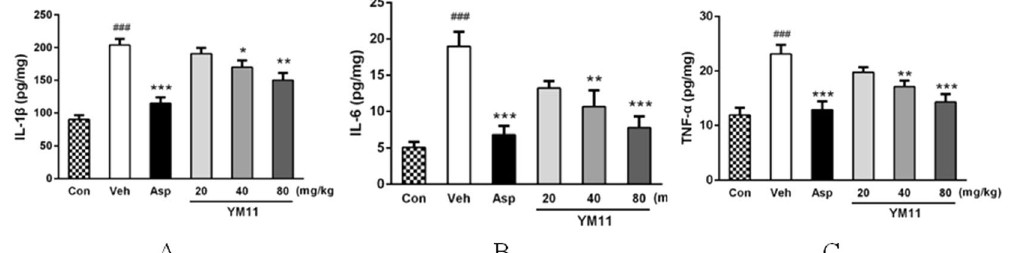
Figure 10. Interleukin-1 β ( A ), Interleukin-6 ( B ) and TNF- α ( C ) levels in supernatants of homogenates from xylene-treated ears after treatment with aspirin (200 mg/kg) or YM 11 (20–80 mg/kg). Measurements were performed with a commercial ELISA kit. Each bar represents the mean ± SEM. The graphic symbols denote the significance levels when compared with control groups. ### P < 0.001 vs . blank control, * P < 0.05, ** P < 0.01, *** P < 0.001 vs .